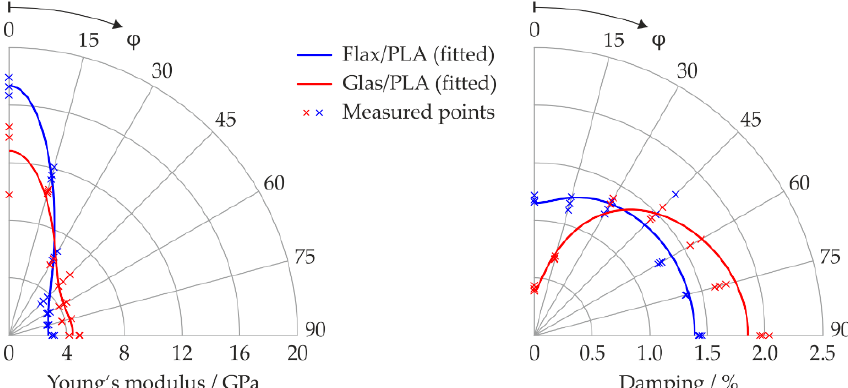
Figure 3. Directional dependence of the dynamical stiffness and material damping of the investi-